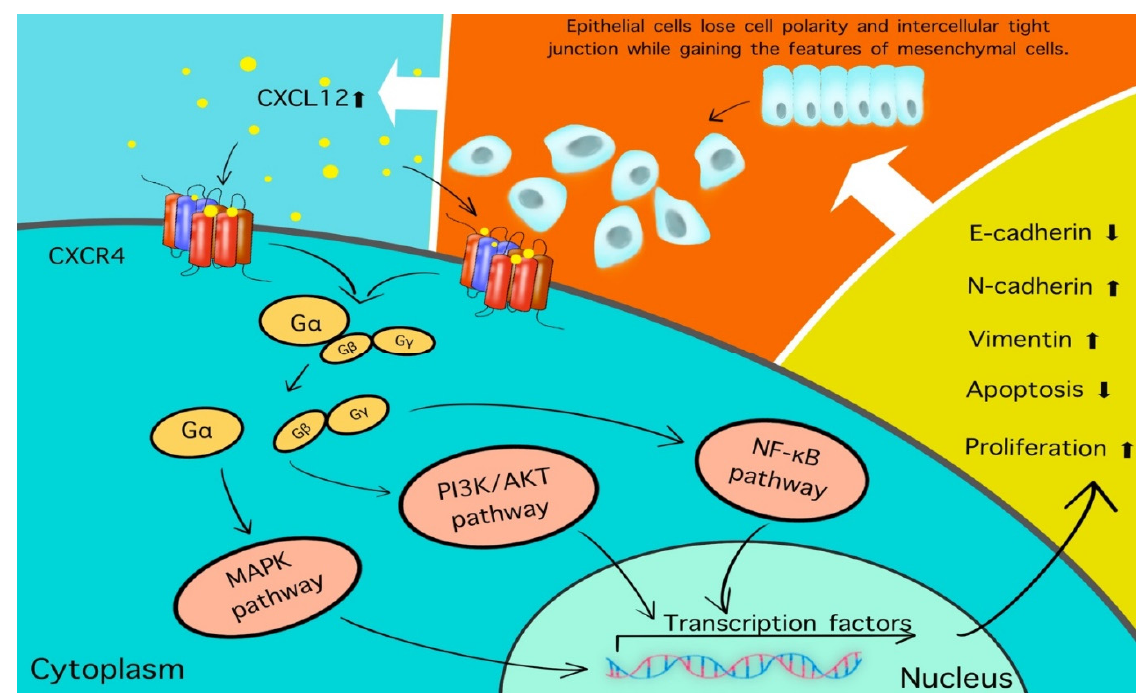
Figure 1. CXCR4, one of the receptors of CXCL12, is expressed on multiple cell types, including lymphocytes, hematopoietic stem cells, epithelial cells, and cancer cells [26]. The binding of CXCL12 to CXCR4 results in the activation of the CXCR4/CXCL12 axis and dissociation of the heterotrimeric protein complex (G αβγ ) to G α and G βγ subunits, which activate a number of signaling pathways including MAPK, PI3K/AKT, and NF- κ B. Ultimately, cell growth, protein synthesis, and inflammation are upregulated. In addition to this change, the E-cadherin will be decreased and the expression of N-cadherin and vimentin will be raised; simultaneously, those cells lose cell polarity and tight intercellular junction while gaining the features of a mesenchymal cell and the capability of migration and invasion. This positive feedback loop stimulates more CXCL12 to be released into the TME to activate the CXCR4/CXCL12 axis.